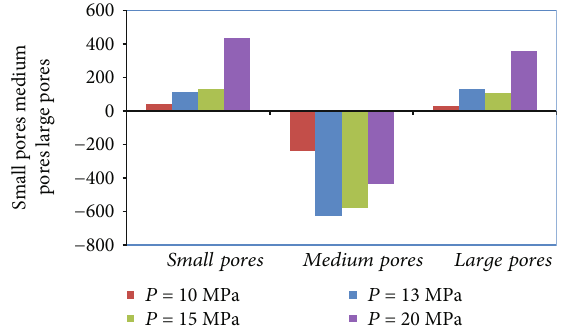
Figure 12: NMRT spectrum of cores saturated with formation water before and after CO 2